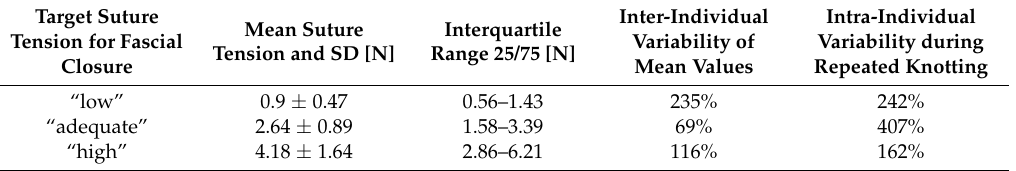
Table 1. Mean suture tension, reproducibility, and precision during mock fascial closure experiment using the knot-trainer.